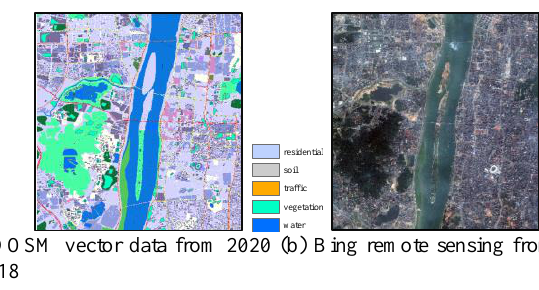
Fig 2. Experiment data for anomaly detection